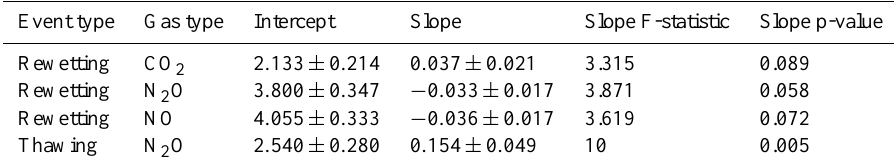
Table 5. Summary statistics of relationship between mean annual temperature and flux change (i.e. peak flux as a percentage of pre-event flux) by gas and rewetting or thawing (Fig.